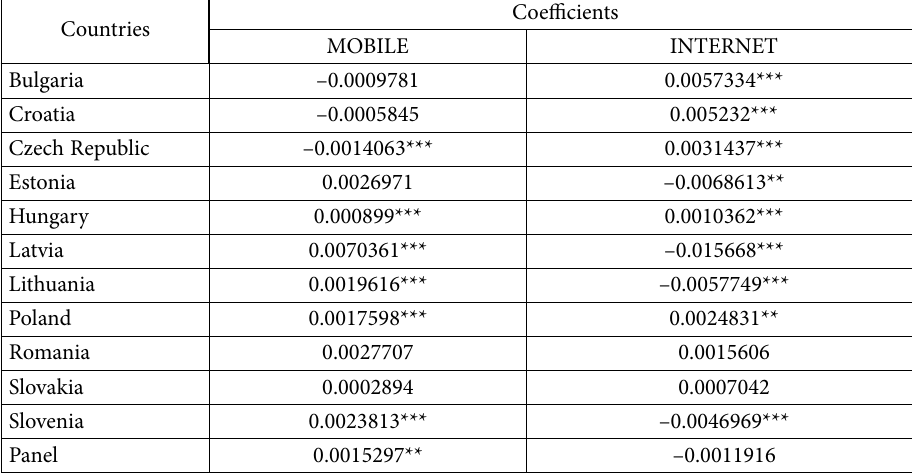
Table 7a. Results of cointegration coefficients’ estimation (Model 1) Countries